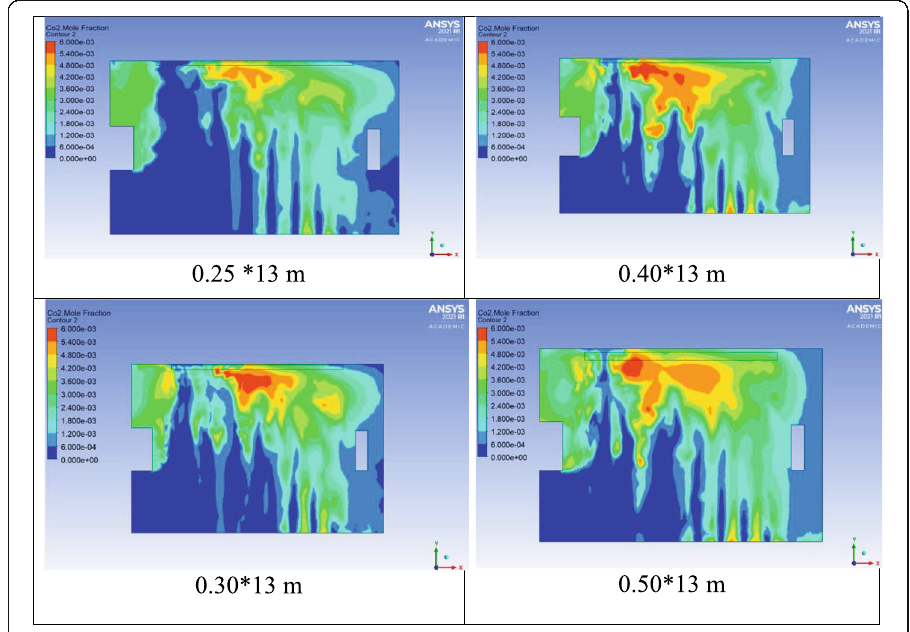
Fig. 12 Contours of CO 2 concentrations (ppm) for the rectangular cross-section (wall chimney) at the breathing level zone (1.2 m), output from the ANSYS CFD model